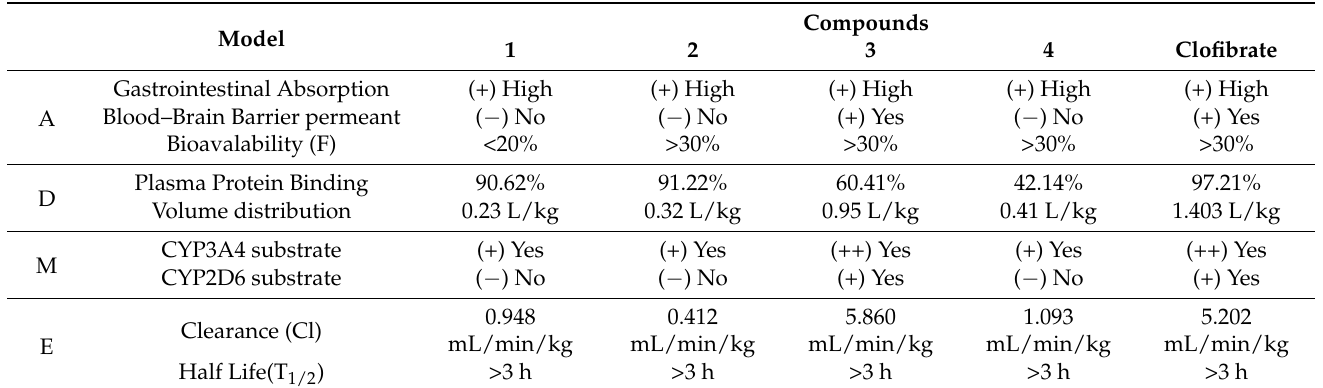
Table 3. Pharmacokinetic predictive values calculated with ADMETLab 2.0